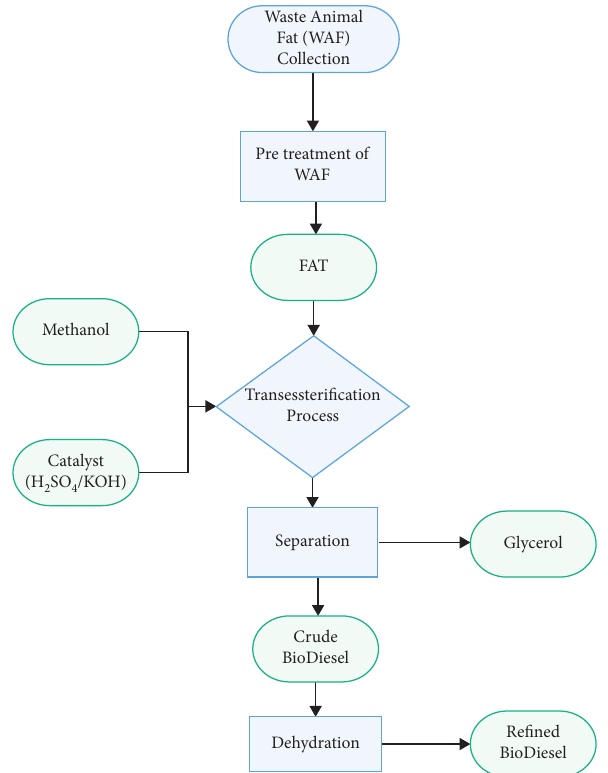
Figure 1: Schematic diagram of the biodiesel production